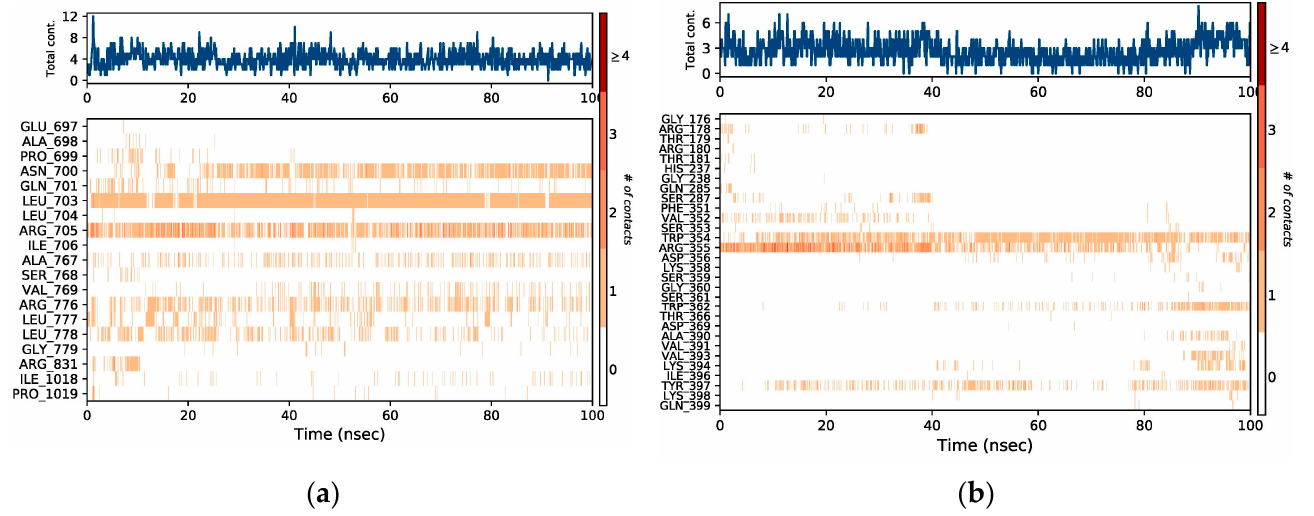
Figure 9. The representation is showing the timeline of the interactions and contacts (hydrogen bonding, hydrophobic interaction, ionic interaction, and water bridges) between ( a ) EGFR-liquoric acid complex and ( b ) caspase-9-limonin complex.